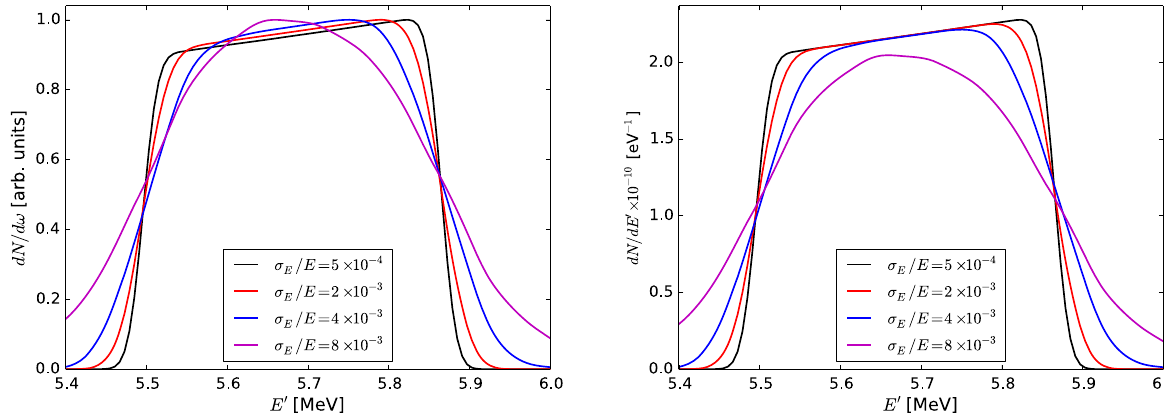
FIG. 4. The number density of the energy spectrum of a Compton gamma-ray beam produced by the head-on collision of a 500 MeV electron with a 800 nm pulsed laser beam, for different relative energy spread of the electron beam σ E as in Fig. 4(b) in Ref. [7]. The laser is collimated by an aperture with radius of 16 mm, placed 60 m downstream from the collision point. The horizontal emittance ε x is held constant at 0.05 nm rad. Here a Gaussian laser pulse with σ ¼ 50 is used, while the laser in Ref. [7] is CW. Each curve is generated by averaging 400 electrons sampling the prescribed distribution. Left panel: Spectra scaled to their respective peak values (compare with Fig. 4(b) of Ref. [7]). Right panel: Spectra in physical